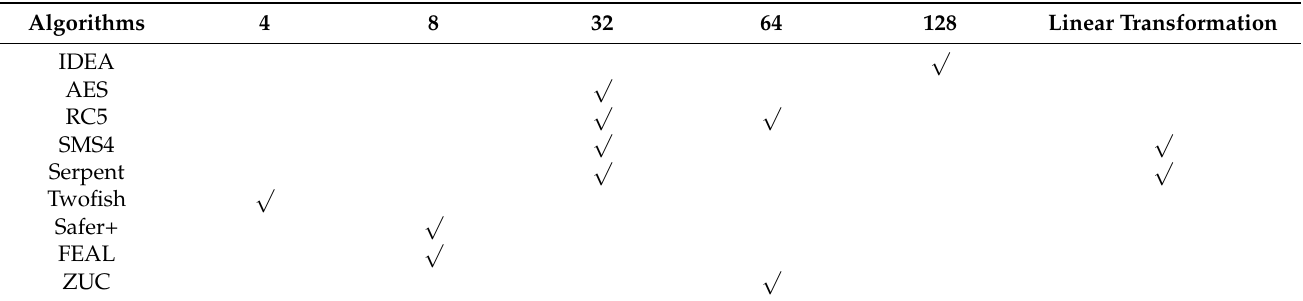
Table 3. Statistics of shift operations in cryptographic